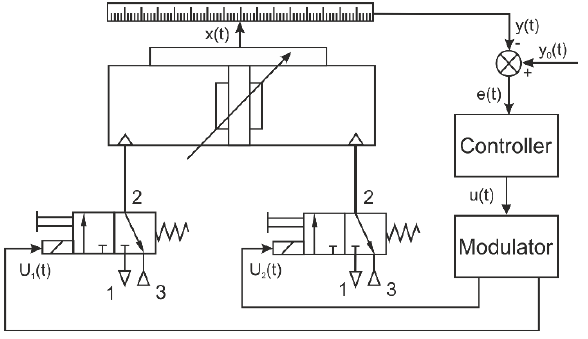
Fig. 1. Diagram of a drive with choking control with two 3/2 directional